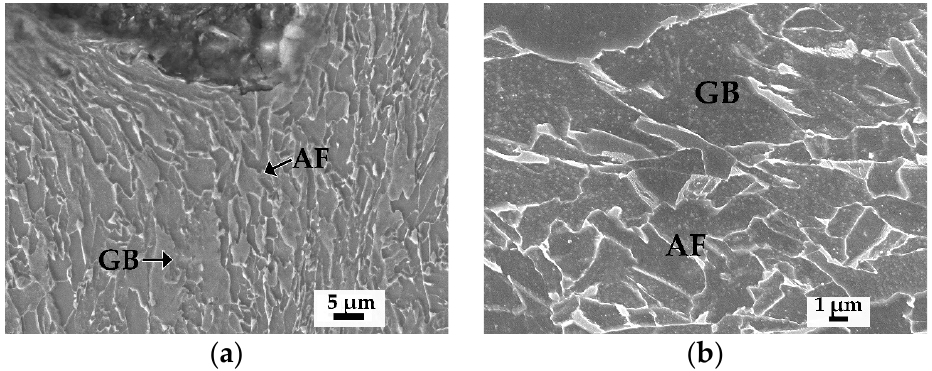
Figure 8. Microstructure near the tip of the delamination crack. ( a ) Low-magnification SEM micro- graph; ( b ) high-magnification SEM micrograph.